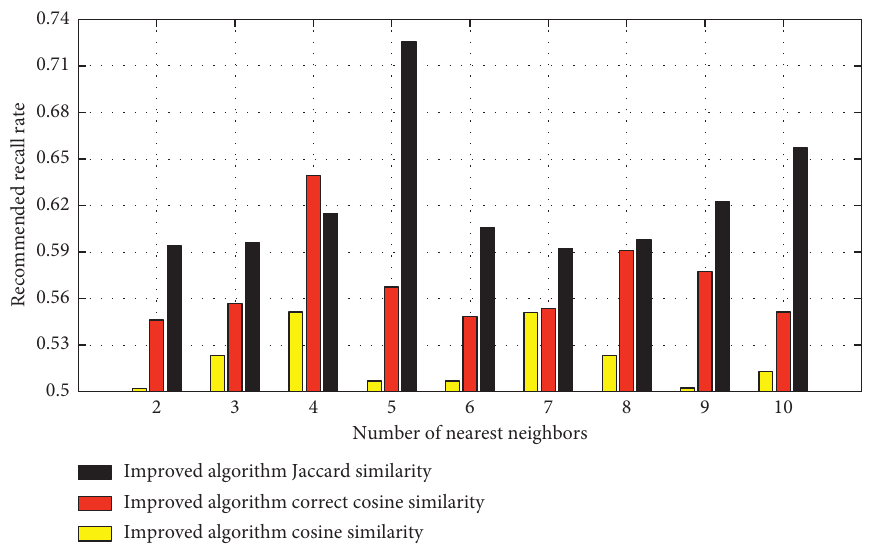
Figure 11: The recall rate of the algorithm in this paper for the recommendation of the first